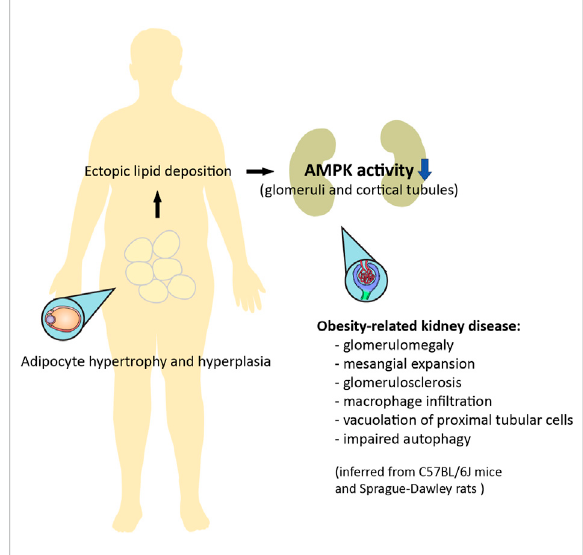
FIGURE 3 Ectopiclipiddepositioninobesitycanresultinnephrotoxicity